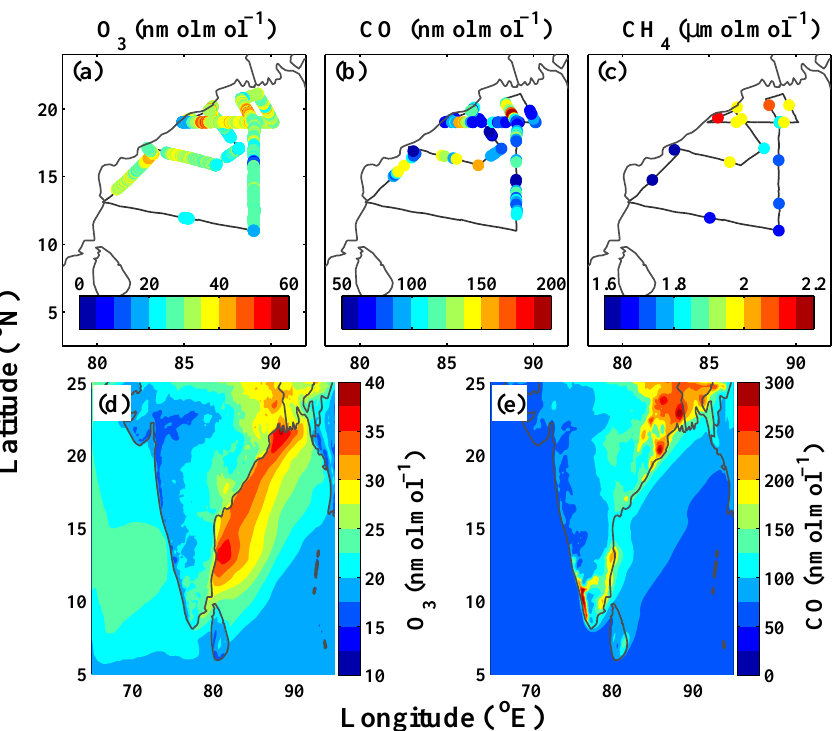
Figure 2. Spatial variation of surface O 3 (a) , CO (b) , and CH 4 (c) mixing ratios along the cruise track during the CTCZ campaign. WRF- Chem simulated spatial distribution of surface O 3 (d) and CO (e) averaged during 16 July–17 August